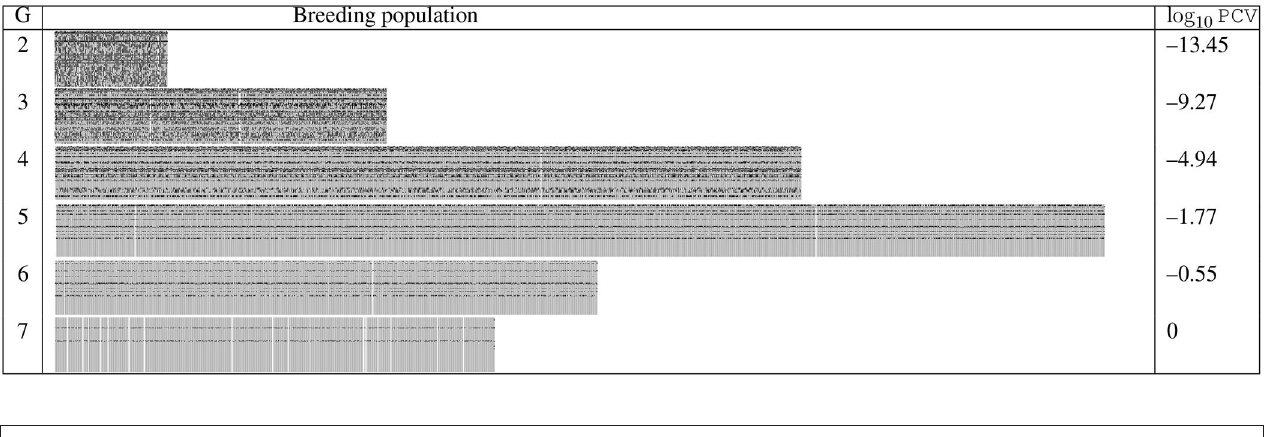
Figure 6 breaks down the cost allocation to different generations for varying levels of total budget. When total budget is less than the optimal level, the model tends to allocate unproportionately higher percentages of budget to early generations, in order to produce enough progeny and preserve genetic diversity for future genetic gains. When total budget exceeds the optimal level, resource allocation to different generations becomes stable. Meanwhile, the model tends to allocate relative more resources on generation 2 and 3 to push the process to succeed in generation 5. However, if it is